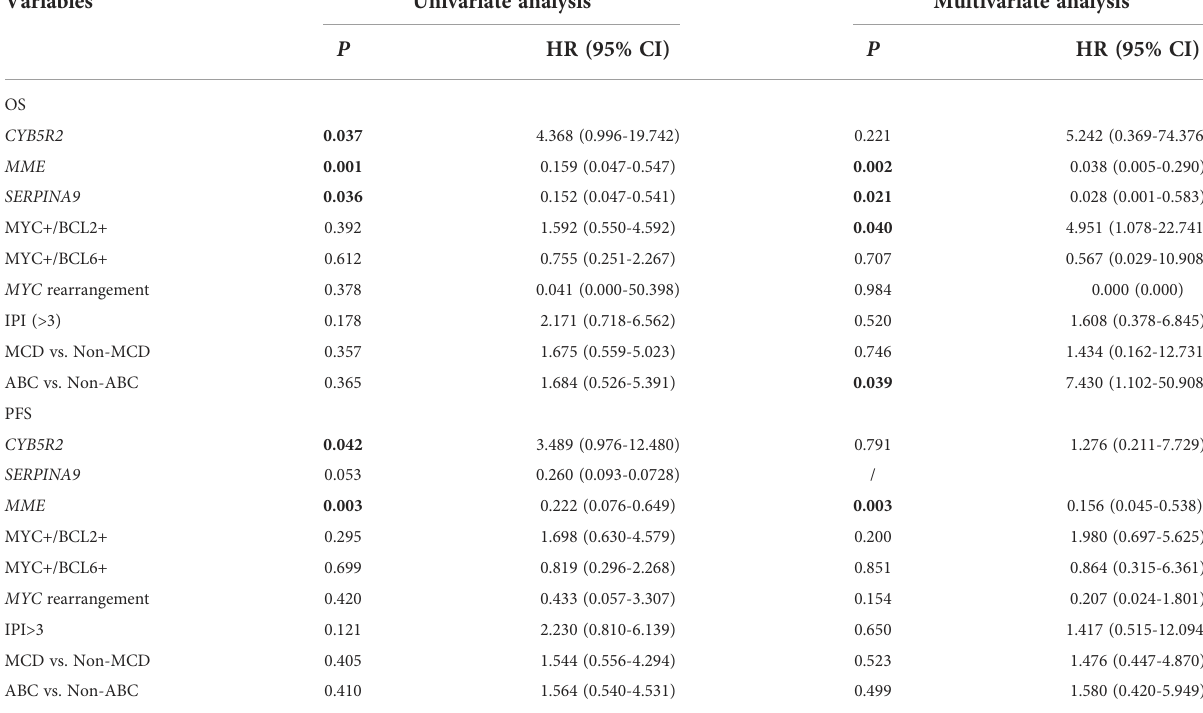
TABLE 3 Univariate and multivariate survival analyses of the mRNA expression of CYB5R2 , MME , and SERINA9 in CD5+ DLBCL.